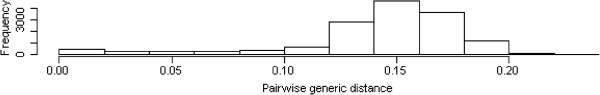
Neighbour-joining tree of ORF5 of Italian PRRSV strains generated in this study (red colour) and three European PRRSV vaccines retrieved from NCBI databases. The green, yellow and blue colours correspond to the vaccines DQ324668, DQ324681 and DQ324678, respectively. The circle highlights the Italian strains that clustered with the vaccines.